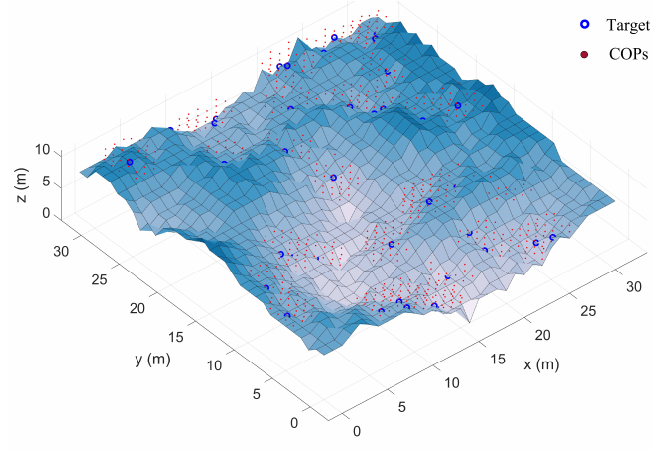
Figure 12. COPs of targets on the complex